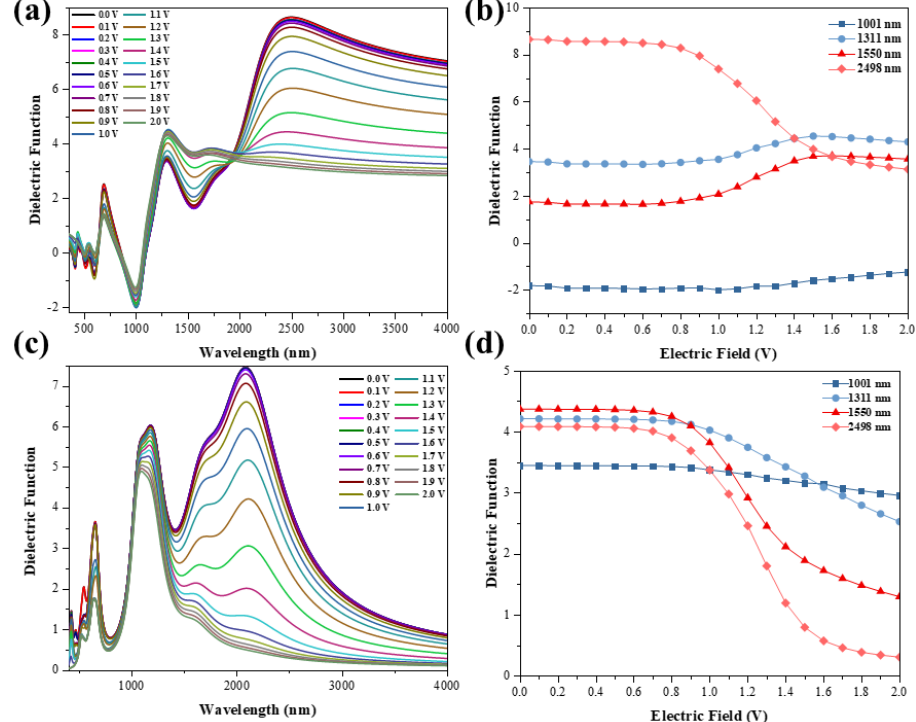
Figure 4. The real ( a ) and imaginary ( c ) parts of the dielectric function of the external electric field induced TBG in the y direction. The variation of the real ( b ) and imaginary ( d ) parts of the dielectric function with the tunable external electric field is analyzed. Field intensity is defined as v/nm.